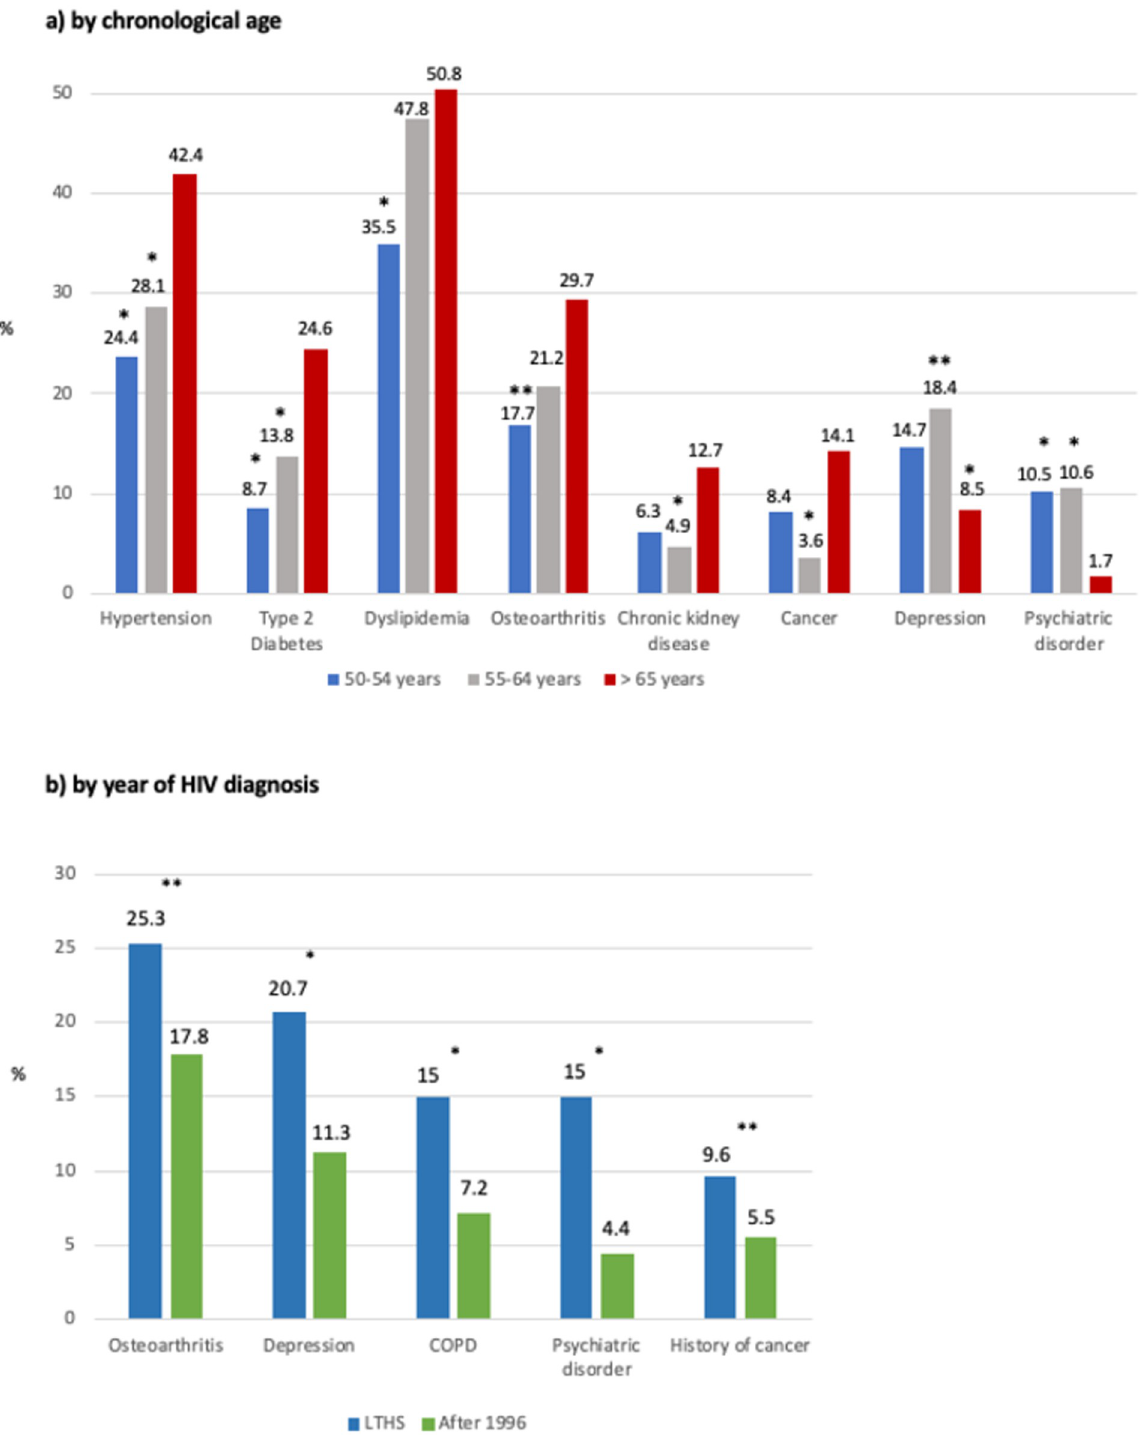
Fig 1. Comorbidities stratified both by chronological age and year of HIV diagnosis. � Significant difference with respect to 65 or over group (p < 0.005) �� Significant difference with respect to 65 or over group (p < 0.01).